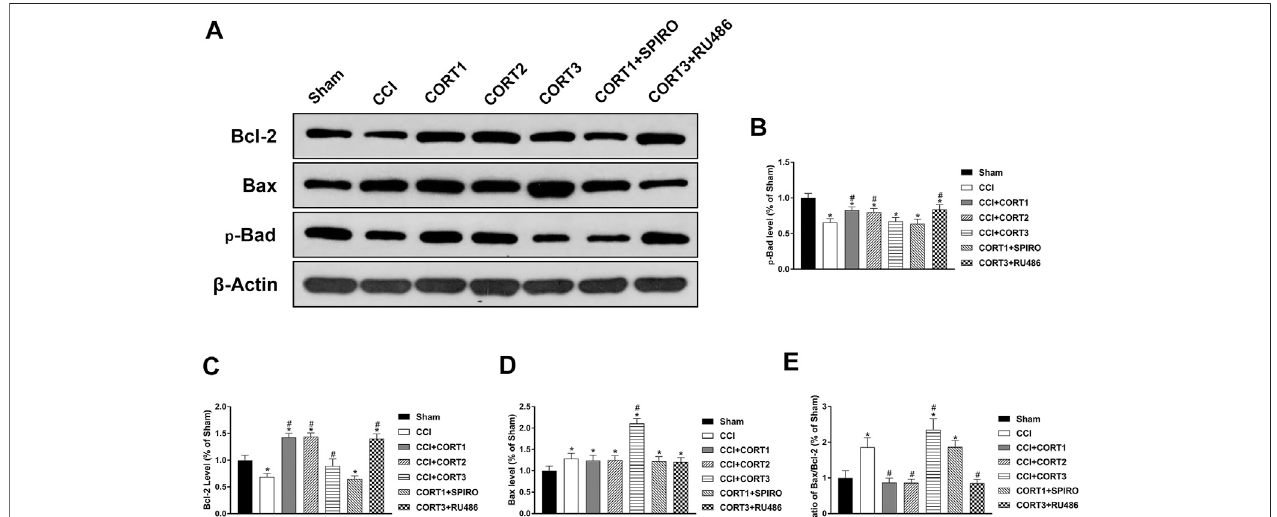
FIGURE 6 | Dose-dependent effects of CORT treatments on the activation and concentration of Bcl-2 family proteins. (A) Representative western blot images of Bcl-2, Bax and p-Bad expression. (B – E) Quanti fi cation of p-Bad, Bcl-2, Bax and Bax/Bcl-2. * p < 0.05 versus the sham control group. The relative band density was measuredwithImageJsoftware(version1.49)andnormalizedtothatof β -actin,andtheconcentrationpercentagecomparedtothatoftheshamcontrolswascalculated for each sample. * p < 0.05 compared to the sham group; # p < 0.05 versus the CCI control group. The data are presented as the mean ± SD of eight animals in each group.